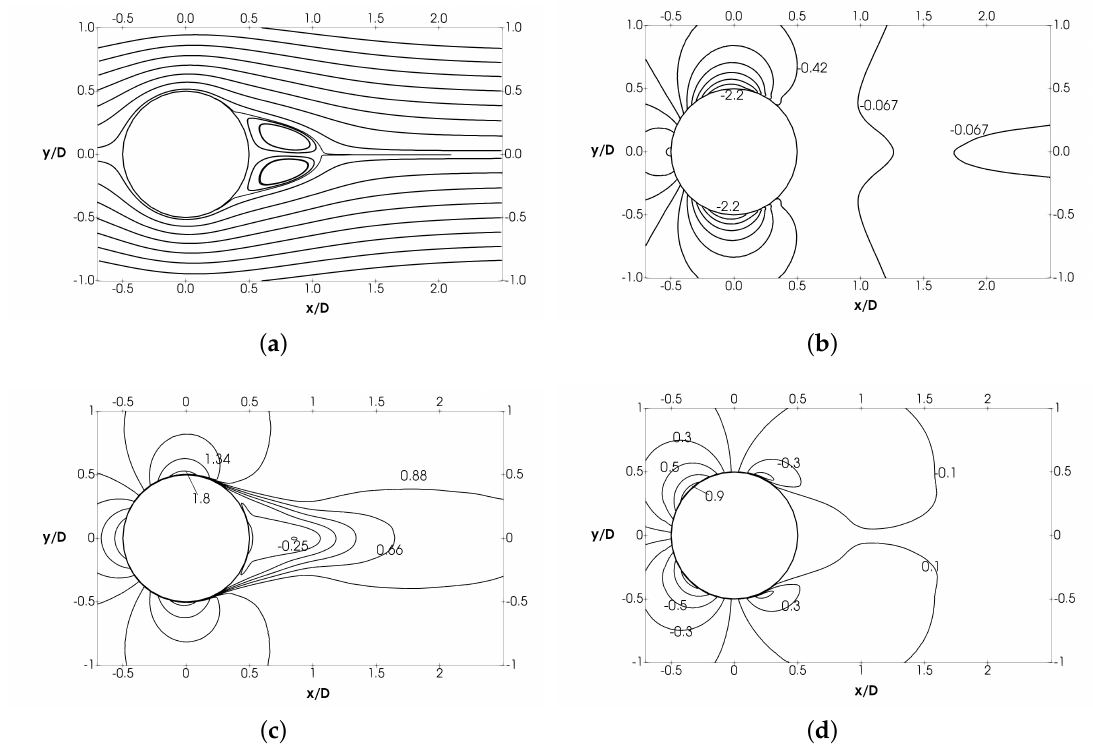
Figure 7. Near wake mean field. ( a ) Streamlines; non-dimensional iso-contours of ( b ) pressure coefficient ( − 2.2 ≤ (cid:104) Cp (cid:105) ≤